Question: Give a one-sentence summary of this figure.
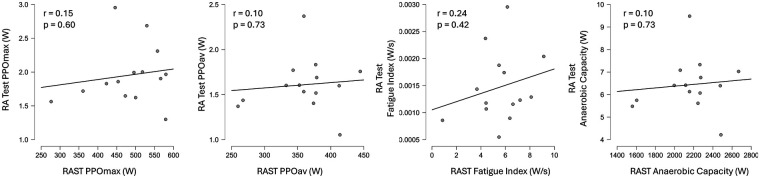
Answer: Relationship between anaerobic performance indices derived from the RA test and RAST illustrated (from left to right) for peak power output (PPOmax), average power output (PPOav), fatigue index (FI) and anaerobic capacity (AC).